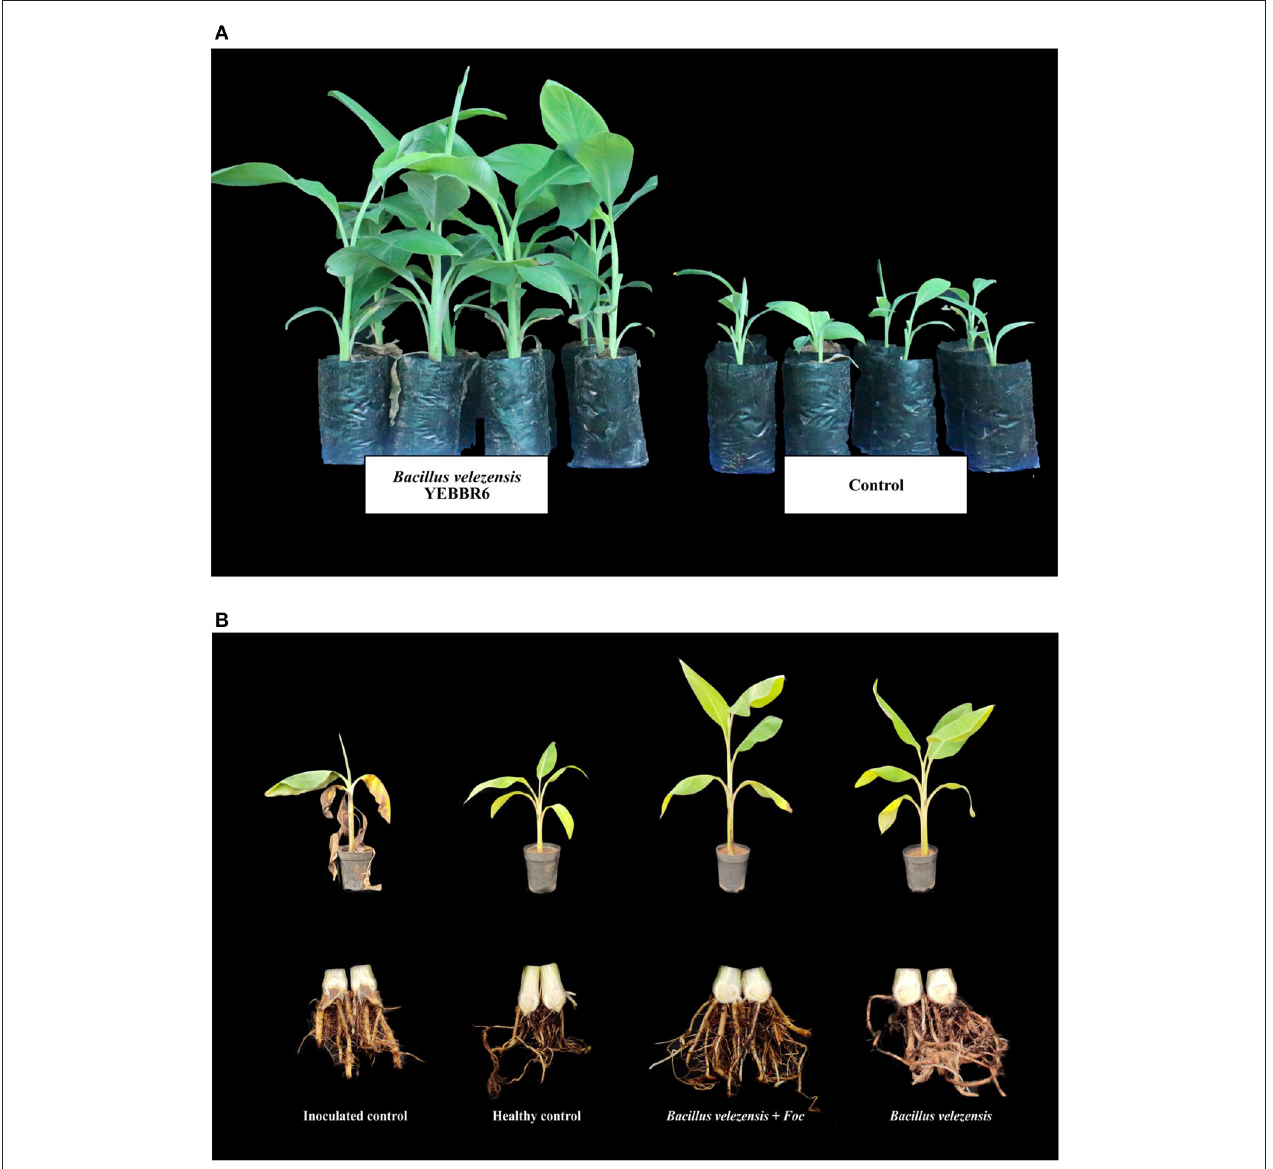
FIGURE 3 | (A) Plant growth promotion of micropropagated banana plantlets biohardened with Bacillus velezensis YEBBR6. (B) Effect of Fusarium wilt on biohardened micropropagated Karpooravalli banana plantlets with Bacillus velezensis YEBBR6 against Foc in pot culture.